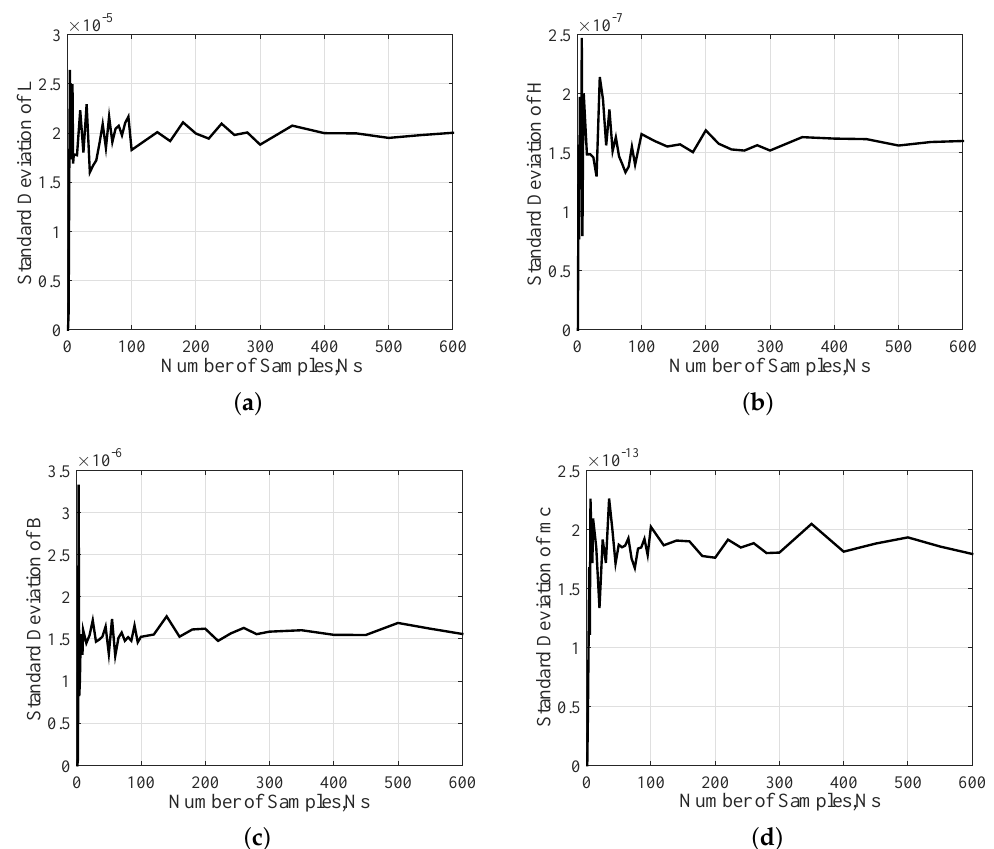
Figure 7. Stochastic convergence analysis of Standard deviation of input parameters: ( a ) L, ( b ) B, ( c ) H and ( d ) m c .